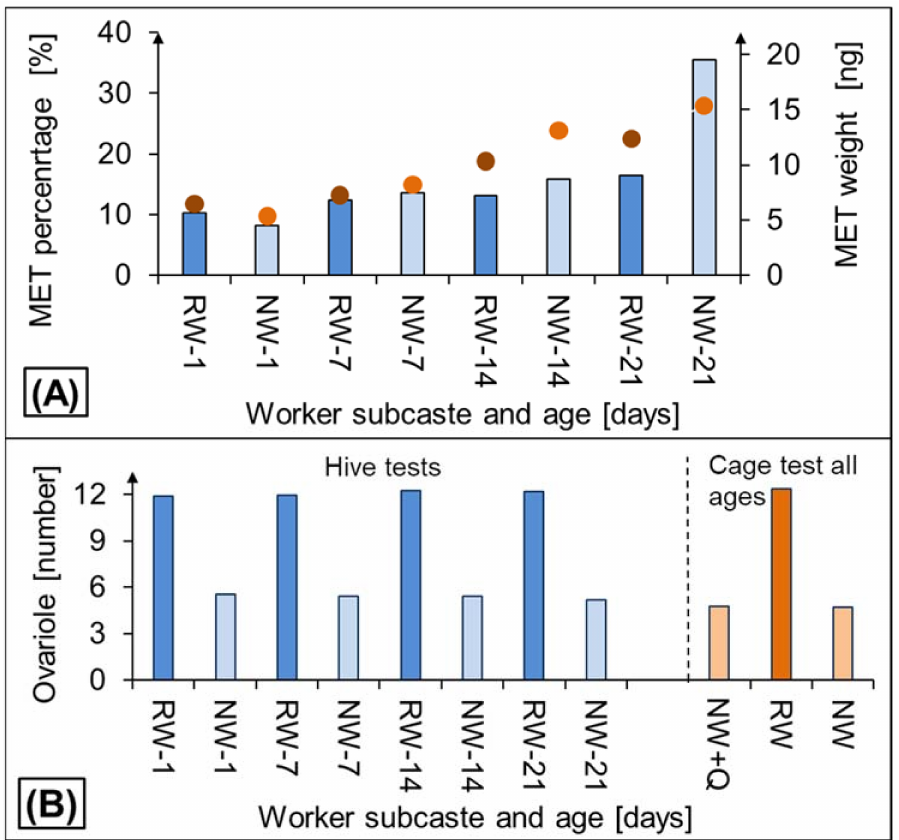
Figure 4. ( A ) Global methylation level (MET) in rebel (RW) versus normal (NW) workers expressed (three-way ANOVA: colony F 2,216 = 1.41; p = 0.246, phenotype: F 1,2 = 2291.77; p < 0.001; day of life: F 3,6 = 4358.95; p < 0.001; Tukey test for day of life p < 0.001 for all comparison) by bars and the methylated cytosines weight expressed by circles (three-way ANOVA: colony F 2,216 = 1.00; p = 0.379, phenotype: F 1,2 = 955.00; p < 0.001; day of life: F 3,6 = 6429.7 p < 0.001; Tukey test for day of life p < 0.001 for all comparison). ( B ) Ovariole numbers in RW and NW kept in hives or cages. RW—rebel workers; NW—normal workers (three-way ANOVA: colony F 2,216 = 8.56; p > 0.379, phenotype: F 1,2 = 8554.68; p < 0.001; day of life: F 3,6 = 0.13 p > 0.05); when RW or NW are followed by the worker age, e.g., RW − 7 or NW − 21 it means 7-day-old rebels or 21-day-old normal workers, respectively; when NW are followed by +Q, workers were accompanied with queen. More details are provided in Supplementary Materials (Table